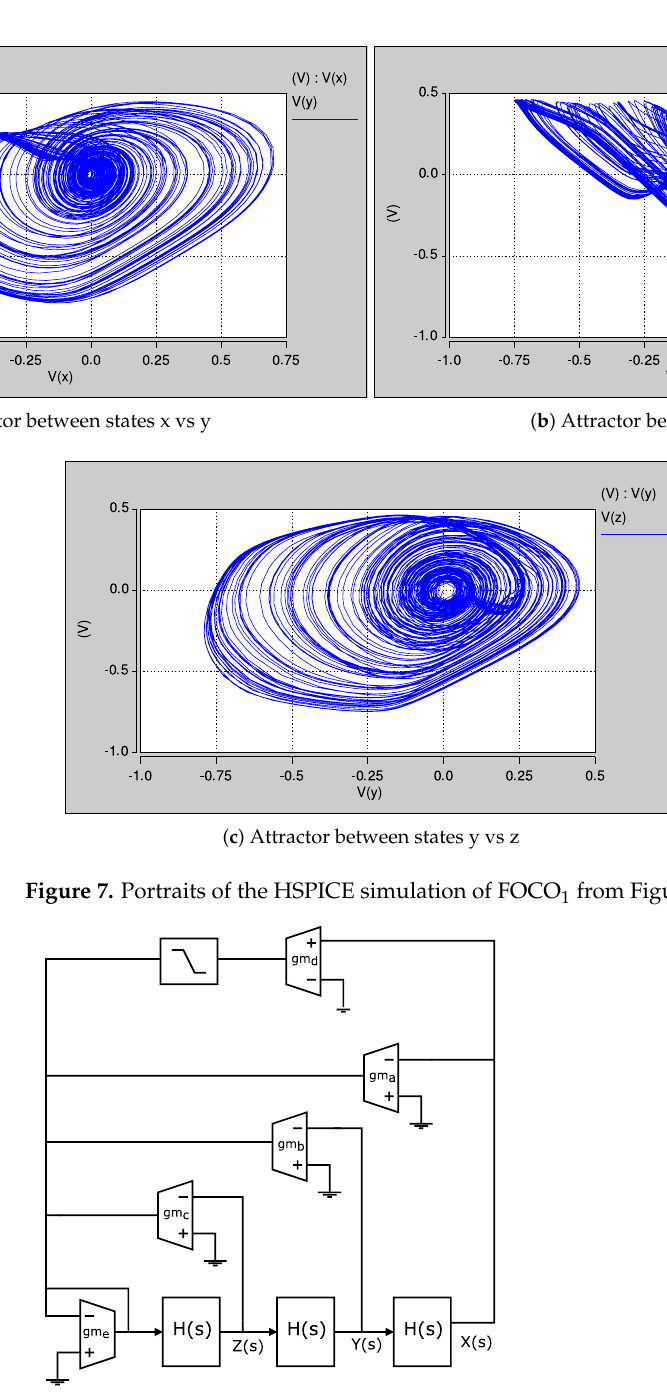
Figure 8. Proposed OTA implementation of the FOCO 2 given in